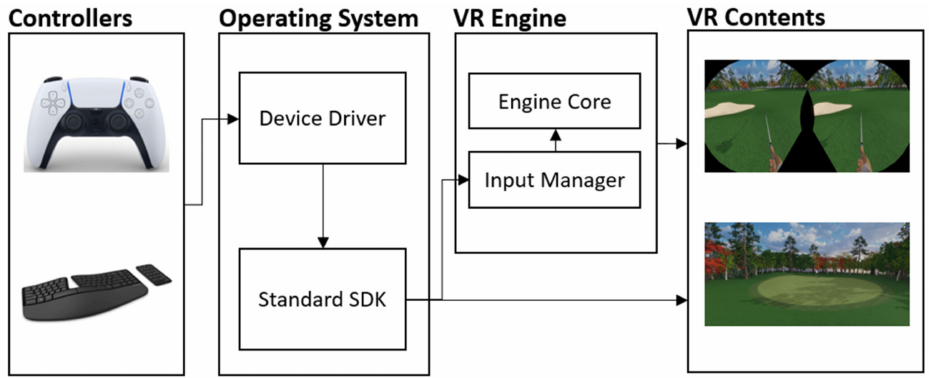
Figure 3. Content development flows when using standard input